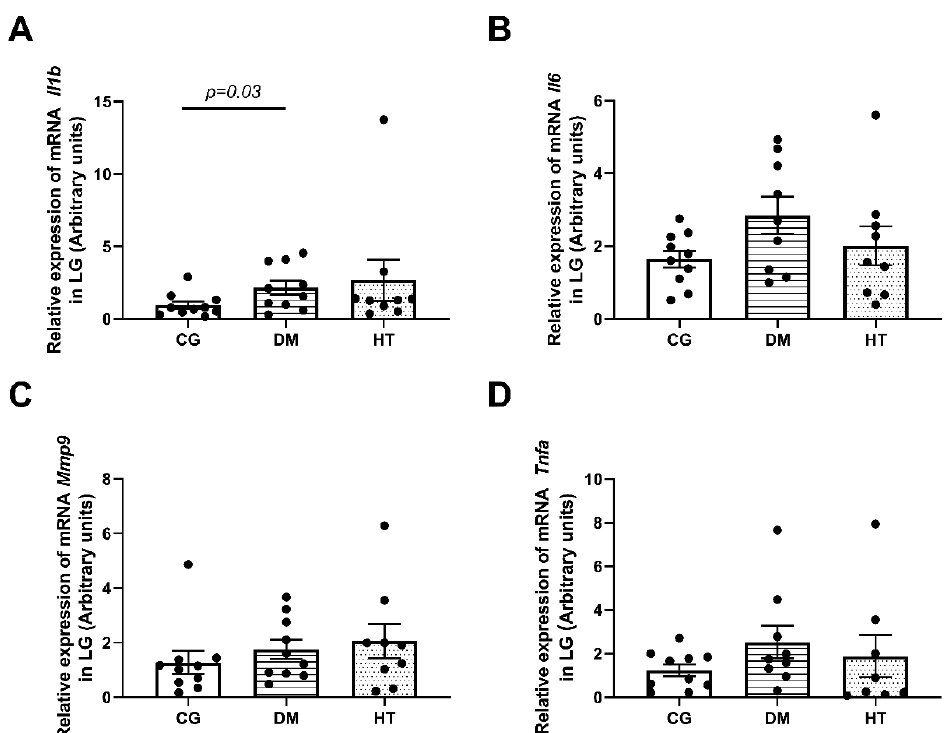
Figure 2. Pro-inflammatory cytokines relative mRNA in the LG. DM group shows a higher expression of Il1b mRNA ( p = 0.03) ( A ). The other cytokines did not present a significant difference from CG ( B – D ). In all tests, n = 10/animals per group. The comparisons were made between DM or HT groups and CG using the Mann–Whitney U test. Each animal value is represented by a black dot in the figure. The pro-mitotic elements with higher mRNA expression in the LG were Runx3 in the HT group ( n = 10/group, p = 0.01). On the other hand, Runx1 presented significantly lower expression in the DM group ( n = 10/group, p = 0.02) (Figure 3). The other pro-mitotic elements’ mRNA expression ( Bmp7 , Fgf10, and Smad1) was similar among the DM, HT, and control groups.